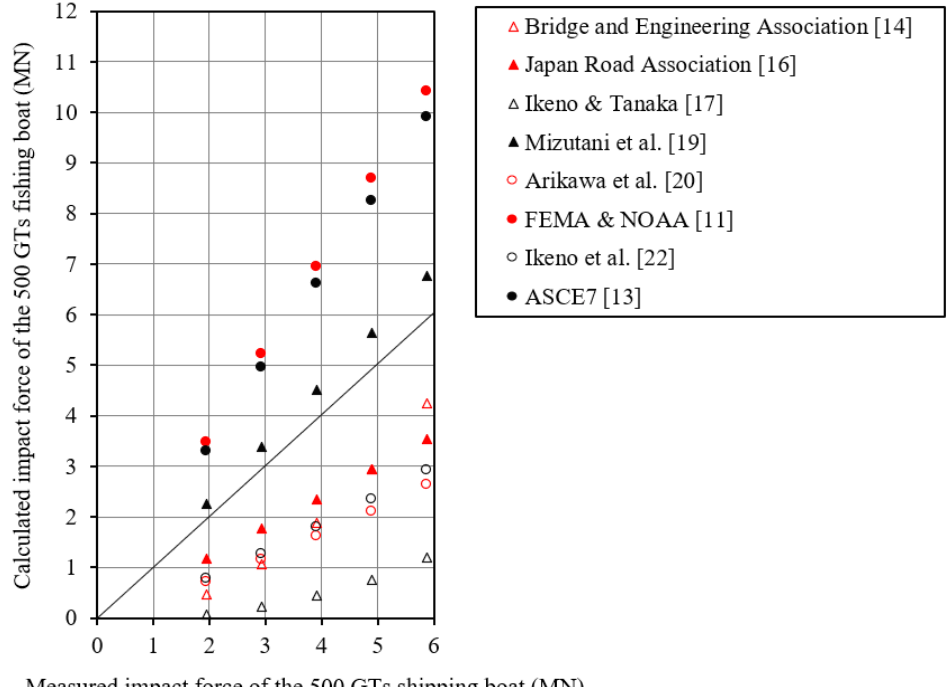
Figure 8. Comparison of impact forces for the ship.